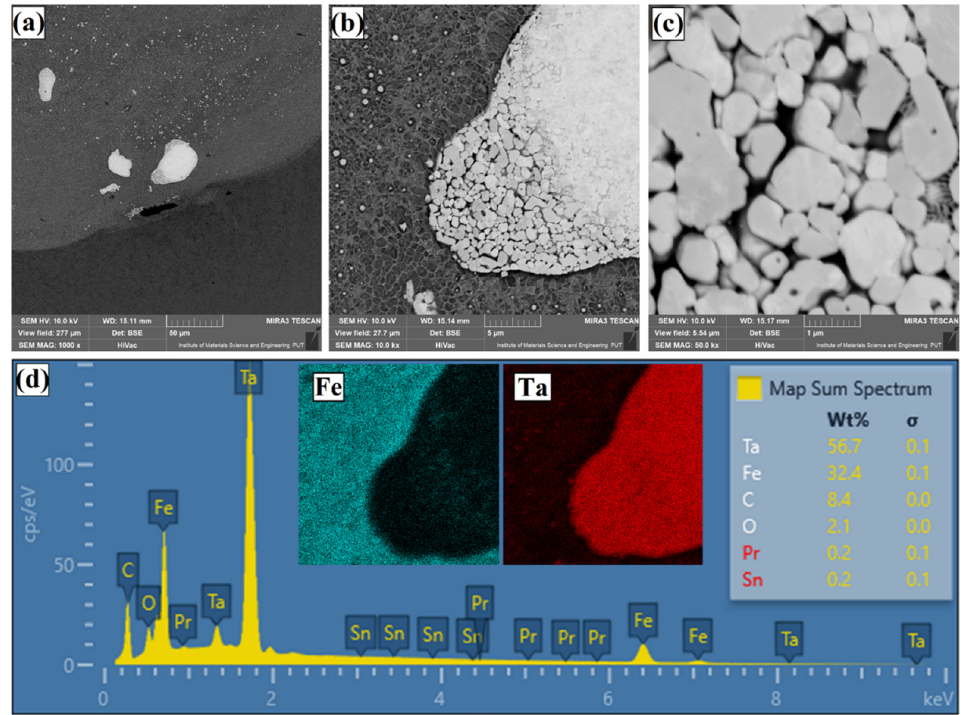
Figure 16. Microstructure and chemical composition of near-substrate area of the Fe/TaC coatings produced on tool steel using 90 µm thick pre-coat and laser beam power of 500 W: the border of melted zone and steel substrate ( a ), view of agglomerated and unmelted TaC powder particles ( b ), enlargement of the unmelted TaC powder particles ( c ), EDS mapping of agglomerated TaC particles ( d ).